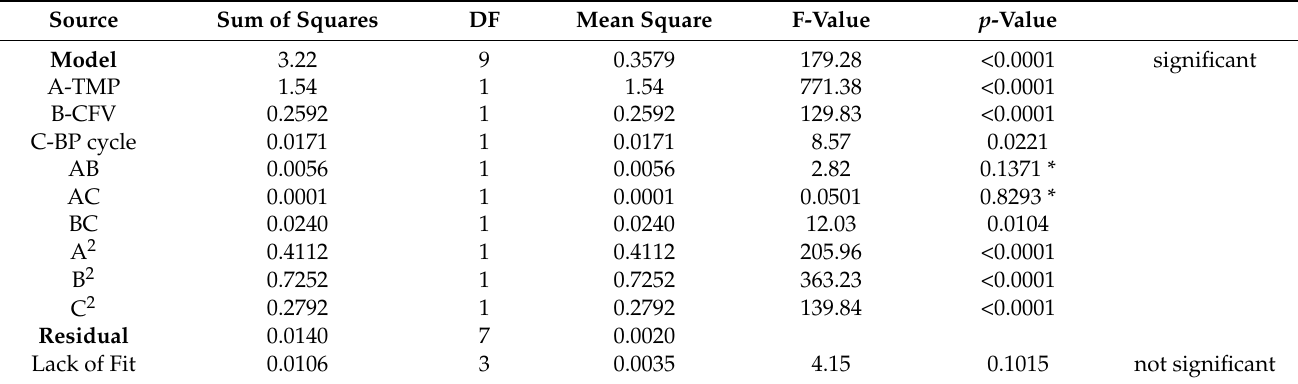
Table 13. ANOVA for the fit of membrane permeate